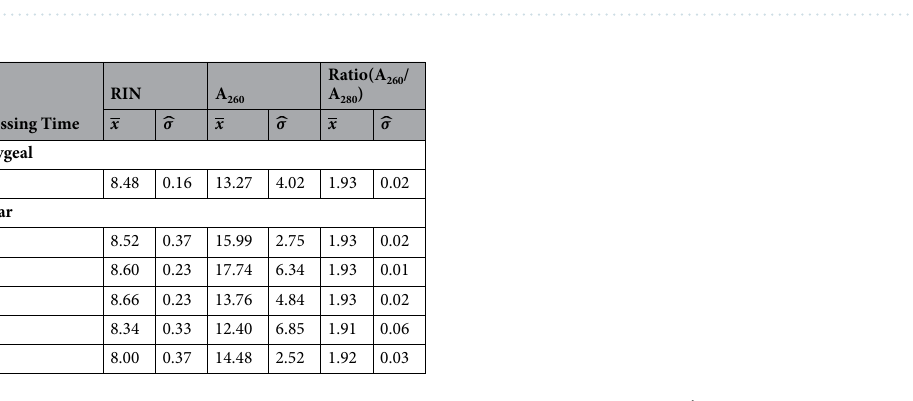
Figure 1. Experimental design and workflow. ( A ) Overview of the experimental design with the number of subjects and tubes processed at different times after storage at 4 °C. ( B ) Workflow of the assays from sample processing to RNA-sequencing. Elements of this figure were created with BioRender.com.